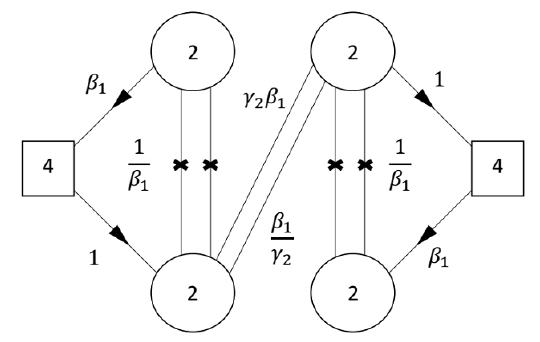
Figure 29 . The theory resulting from gluing the tubes I and II